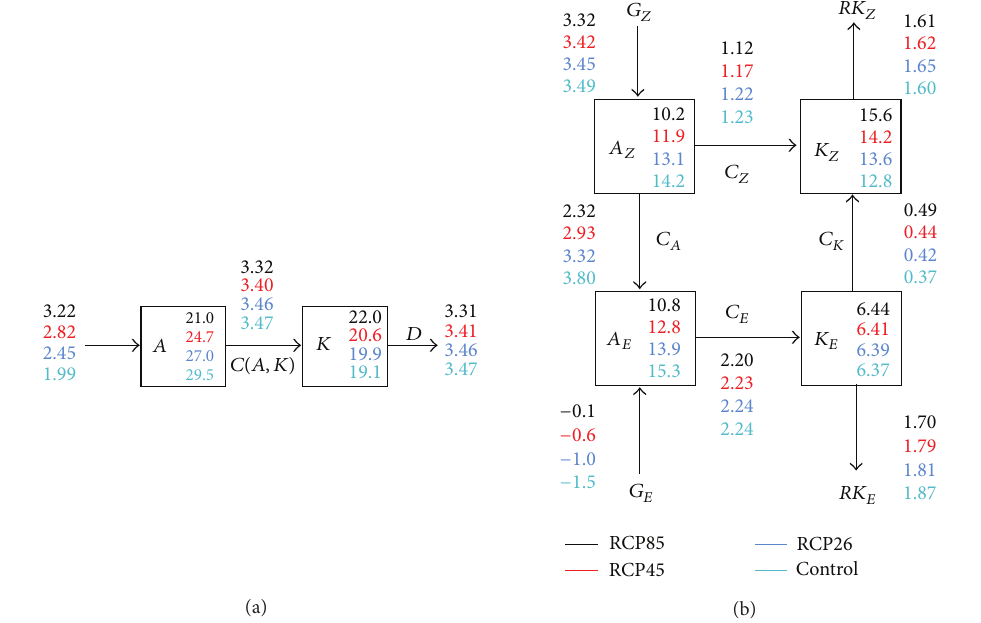
Figure 4: Representation of annual mean of spatial domain Lorenz energy cycle for the entire globe in which (a) is representative of a two- component energy cycle and (b) denotes the four-components diagram. Values from up to below in each figure are for RCP85, RCP45, RCP26, and control experiments. Units are 10 5 J/m 2 for reservoirs and W/m 2 for conversion, generation, and dissipation terms. In the two-component energy cycle the value of 𝐺 is given by the sum of its zonal and eddy part (𝐺 = 𝐺 𝐸 + 𝐺 𝑍 ) , 𝐴 = 𝐴 𝑍 + 𝐴 𝐸 , 𝐶(𝐴,𝐾) = 𝐶 𝑍 + 𝐶 𝐸 , 𝐾 = 𝐾 𝑍 + 𝐾 𝐸 , and 𝐷 = 𝑅𝐾 𝑍 + 𝑅𝐾 𝐸 . Arrows indicate the direction corresponding to positive values; negative values imply opposite flux